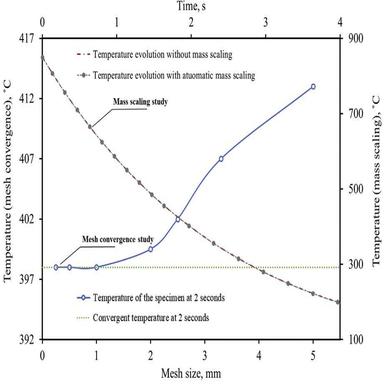
The studies of mesh convergence and mass scaling.